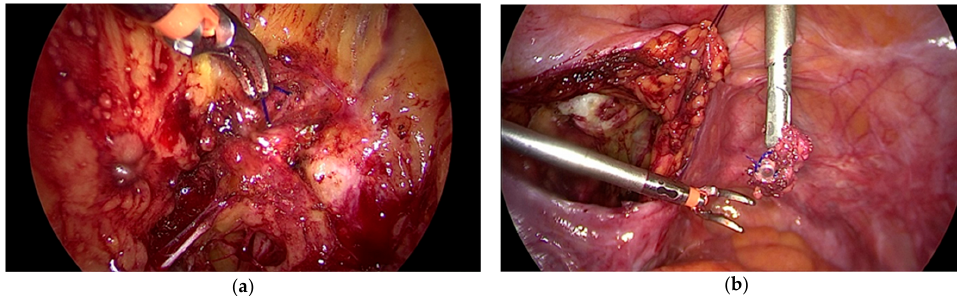
Figure 1. ( a ) Anchor placed in the lateral pelvic fascia instead of the sacrispinous ligament ( b ) (removed anchor on the right